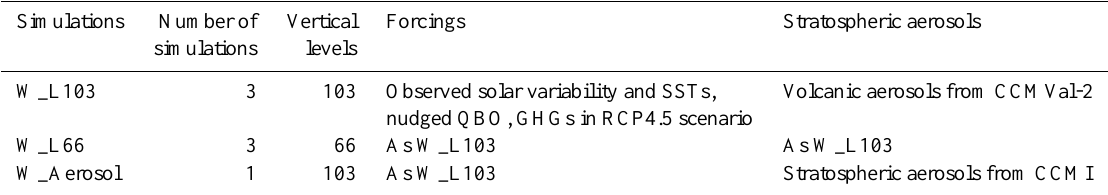
Table 2. Overview of WACCM atmospheric stand-alone simulations (2001–2010). Simulations Number of Vertical Forcings Stratospheric aerosols simulations levels W_L103 3 103 Observed solar variability and SSTs, Volcanic aerosols from CCMVal-2 nudged QBO, GHGs in RCP4.5 scenario W_L66